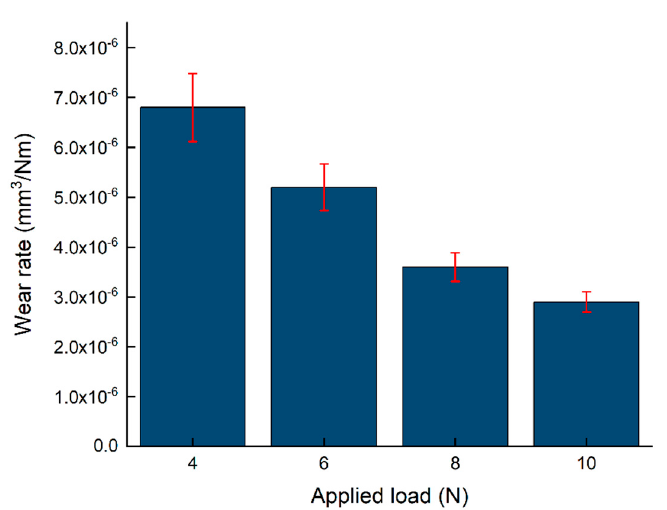
Figure 8. Specific wear rates of cold-sprayed Cu-10Sn coatings under varying applied loads.